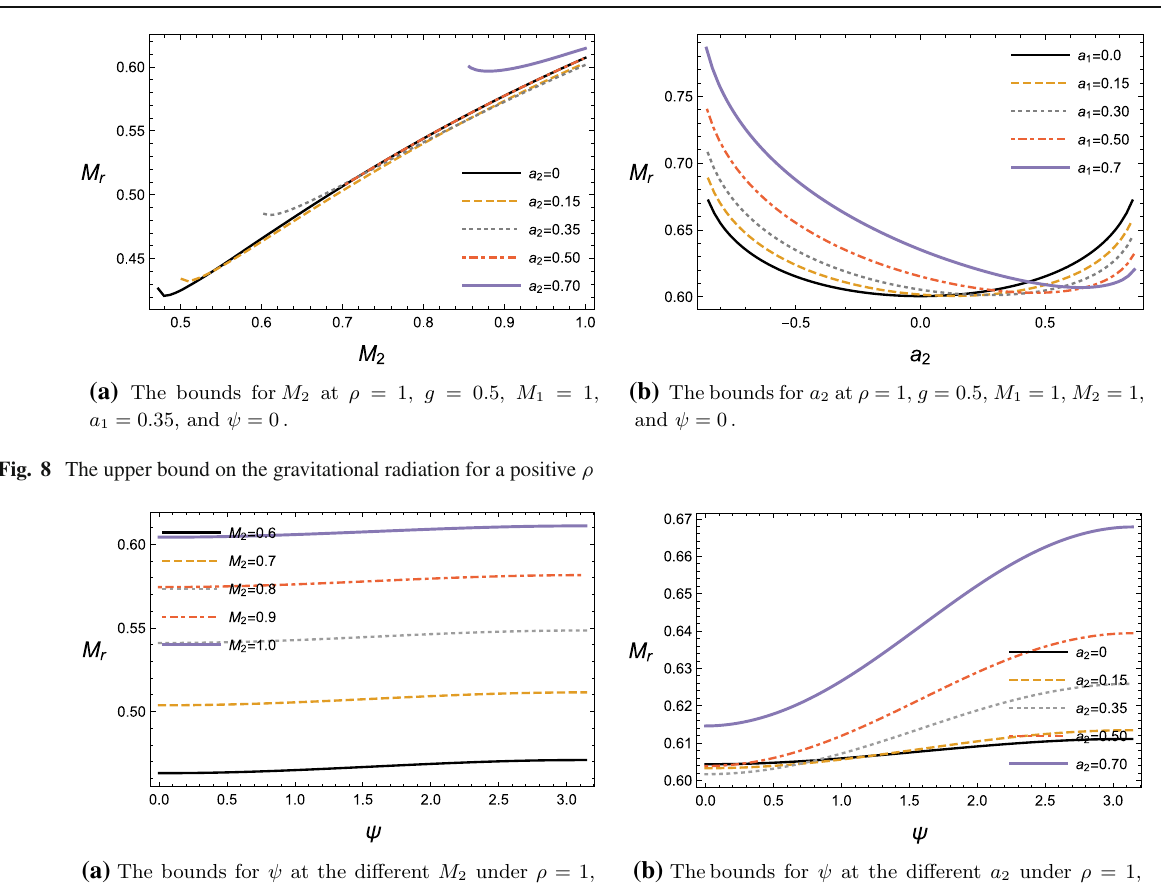
( a ) The bounds for ψ at the different M 2 under ρ = 1, g = 0 . 5, M 1 = 1, a 1 = 0 . 35, and a 2 = 0 . 1. Fig. 9 The upper bound on the gravitational radiation for a positive